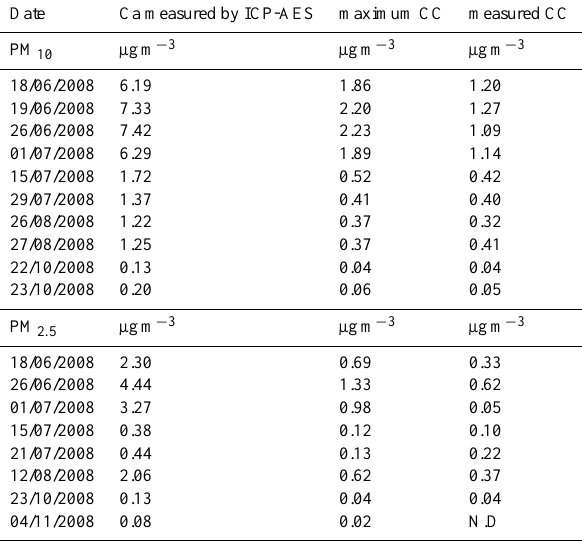
Table 4. Comparison of the maximum CC concentrations (deter- mined as 0.3times the calcium concentration) with the measured CC concentrations for PM 10 and PM 2 . 5